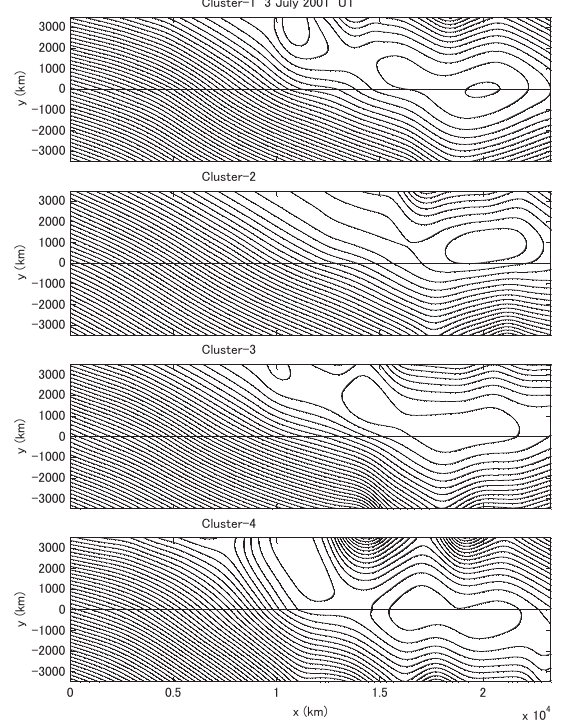
Fig. 4. Magnetic field maps, each reconstructed for the interval 1 using the magnetic field measurements along each spacecraft tra- jectory as spatial initial values. Black contour lines represent the transverse (in-plane) magnetic field lines.